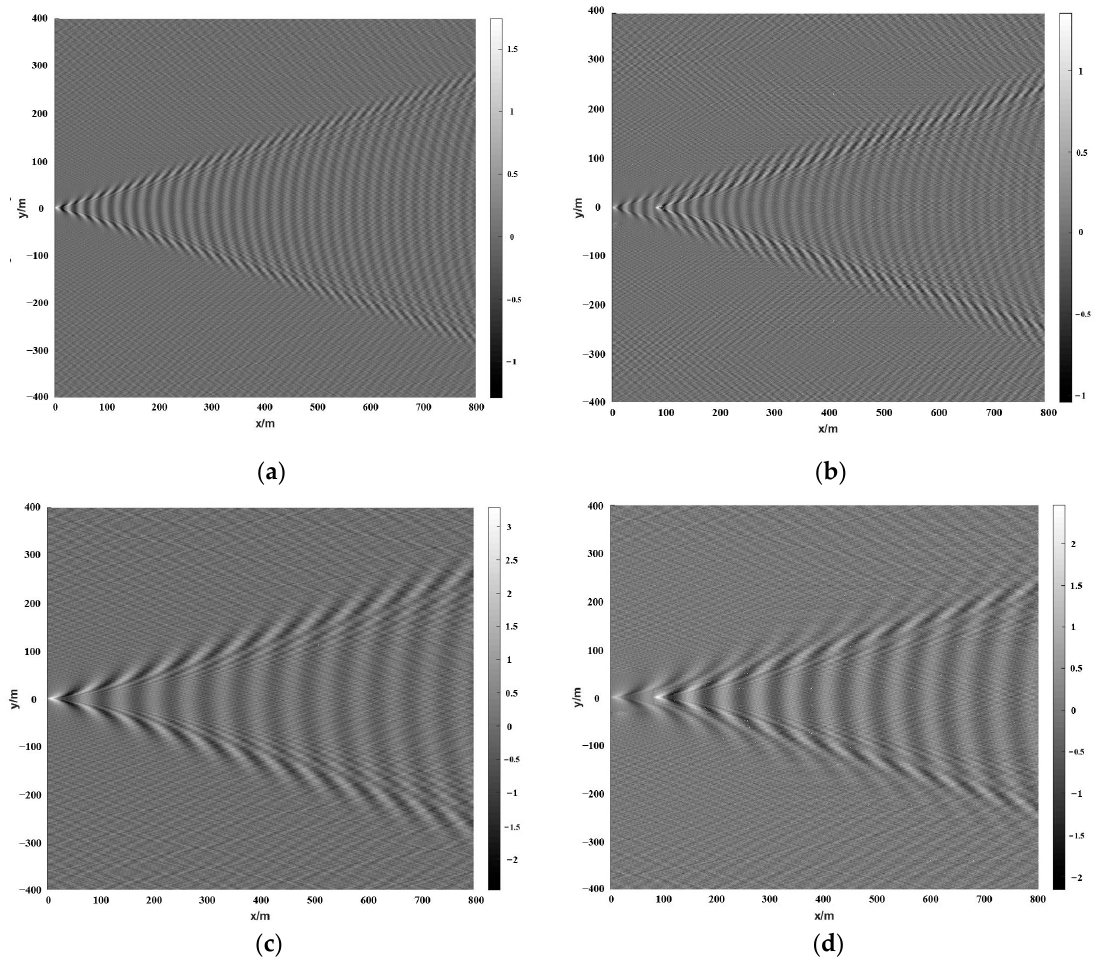
Figure 4. Simulation results of Kelvin wake under different conditions: ( a ) U = 6 m/s, viscous effects are not considered; ( b ) U = 6 m/s, considering the viscous effect; ( c ) U = 10 m/s, viscous effects are not considered; ( d ) U = 10 m/s, considering the viscous effect.